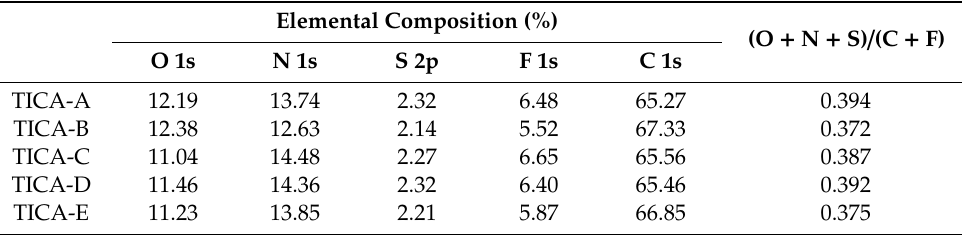
Table 4. The XPS data of TICA crystal habits.